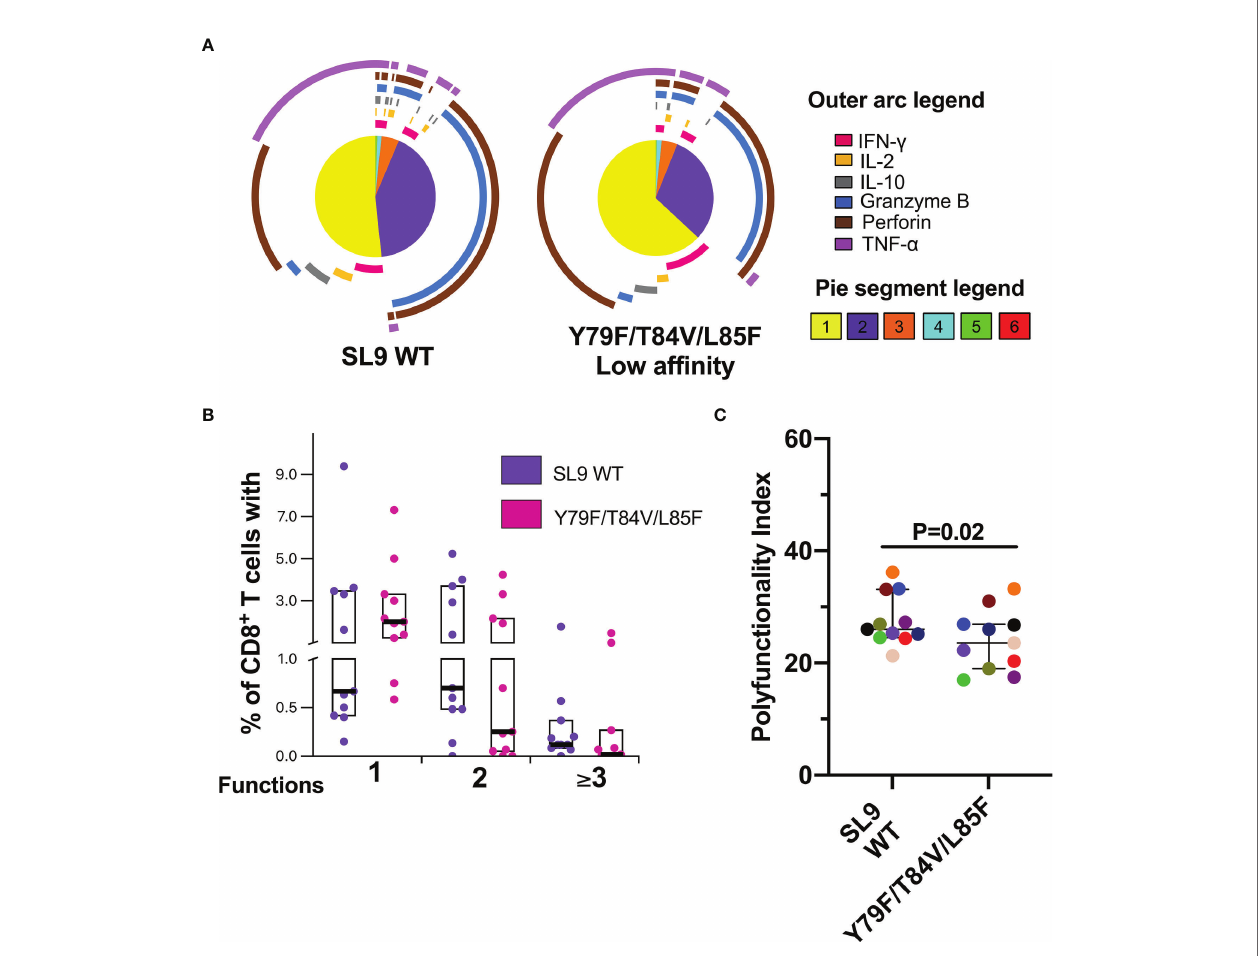
FIGURE 6 | Polyfunctional CD8 + T-cell response to SL9 WT and Y79F/T84V/L85F. (A) Pie charts represent the average frequencies of CD8 + T-cells cells secreting cytokines and cytotoxic molecules producing every possible combination of the six molecules analyzed in response to SL9 WT and mutated peptides (10 µg/mL). The size of the pie segment correlates to the frequency of the particular population. The arcs around the circumference indicate the particular molecule (see outer arc legend) produced by the proportion of cells that lie under the arc. Parts of the pie surrounded by multiple arcs represent polyfunctional cells. (B) Percentage of cells responding through one, two, or more than three functions. (C) Polyfunctionality index. Wilcoxon test was used for comparison. Plots depict the median and IQR, n =